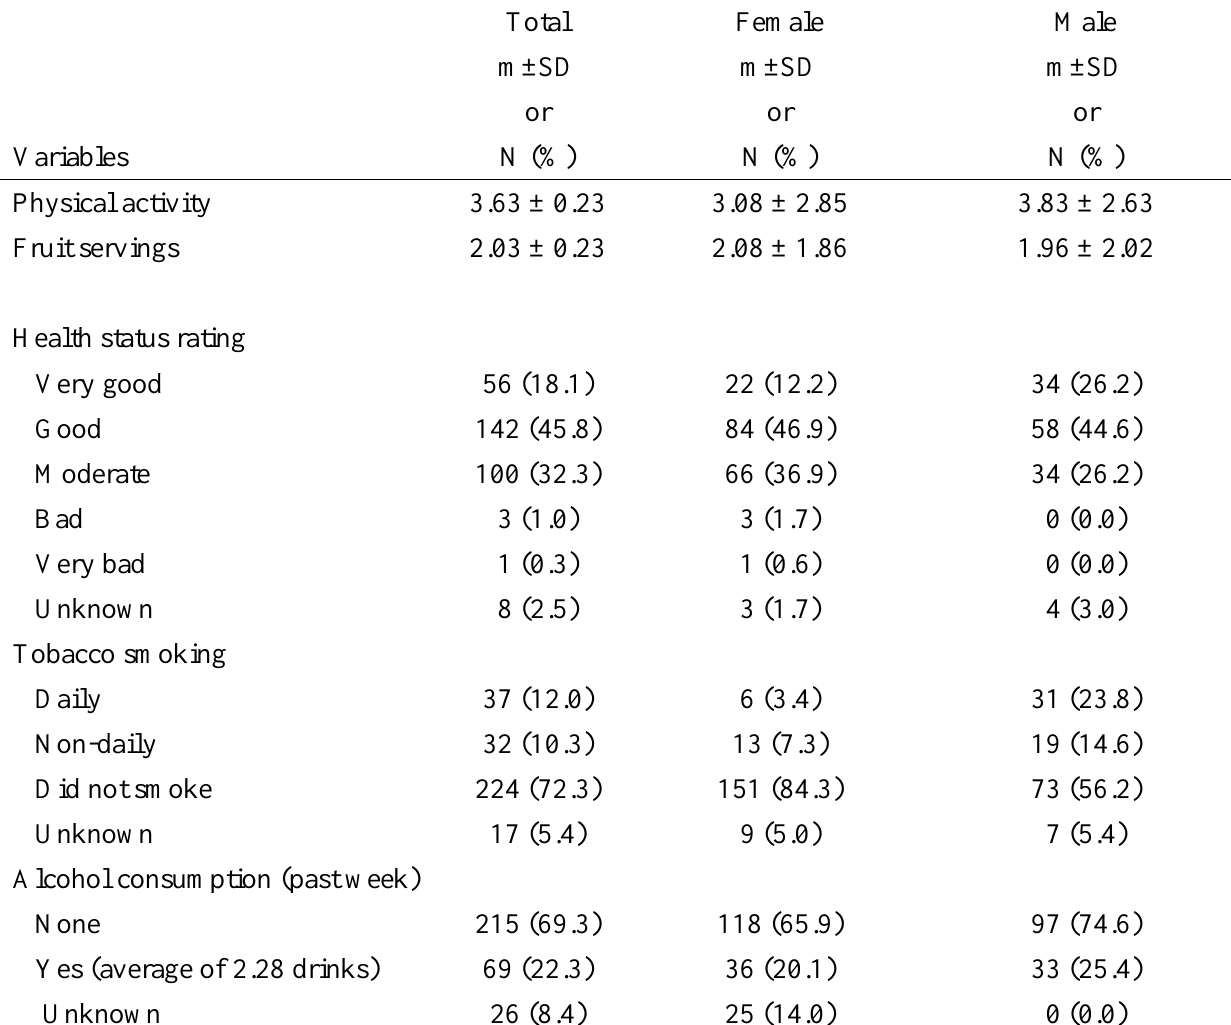
Table 3. Descriptive characteristics of participant